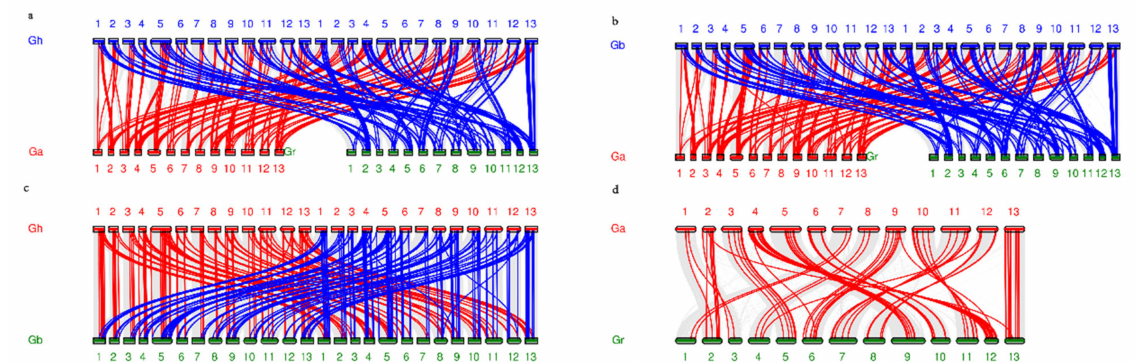
Figure 4. The syntenic relationship between the AATs of four G. species. ( a ) The synteny of GhAATs between G. hirsutum L. and G. arboreum L. labeled with red lines and the synteny of GhAATs between G. hirsutum L. and G. raimondii L. labeled with blue lines. The grey lines indicated all the syntenic relationships in three G. genomes. ( b ) The synteny of GbAATs between G. barbadense L. and G. arboreum L. labeled with red lines and the synteny of GbAATs between G. barbadense L. and G. raimondii L. labeled with blue lines. The grey lines indicated all the syntenic relationships in three G. genomes. ( c ) The synteny of GhAATs between G. hirsutum L. and G. barbadense L. labeled with red lines and the synteny of GbAATs between G. barbadense L. and G. hirsutum L. labeled with blue lines. The grey lines indicated all the syntenic relationships in two G. genomes. ( d ) The synteny of GaAATs between G. arboreum L. and G. raimondii L. labeled with red